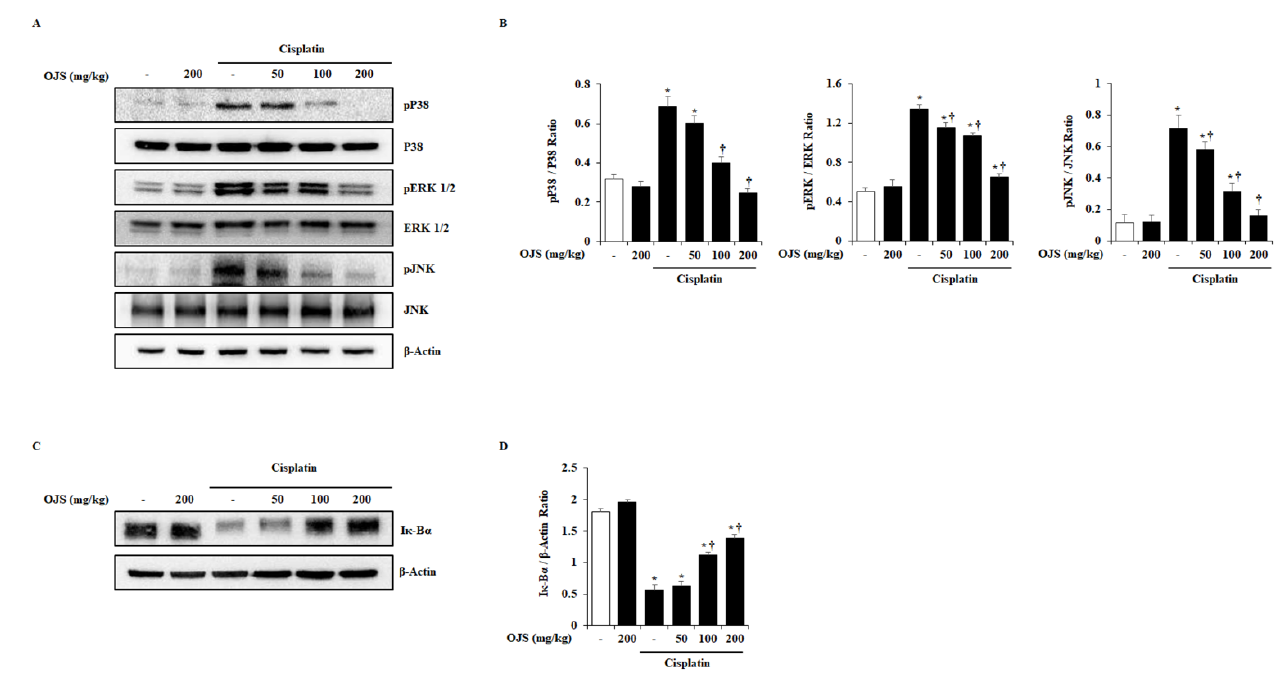
Figure 5. OJS treatment inhibits the activation of MAPK and NF- κ B pathways in cisplatin-induced AKI. ( A ) The phosphorylation levels of p38, ERK1/2, and JNK were analyzed by western blotting. Total p38, ERK1/2, and JNK were used as loading controls. ( B ) The relative density ratio of phosphorylated form/total form. ( C ) The degradation of Iκ - Bα was analyzed by western blotting. β -actin was used as a loading control. ( D ) The relative density ratio of Iκ - Bα / β -actin. Data are represented as mean ± S.E.M. ( n = 6; * indicates p < 0.05 vs. saline-treated control group, † indicates p < 0.05 vs. cisplatin treatment alone).